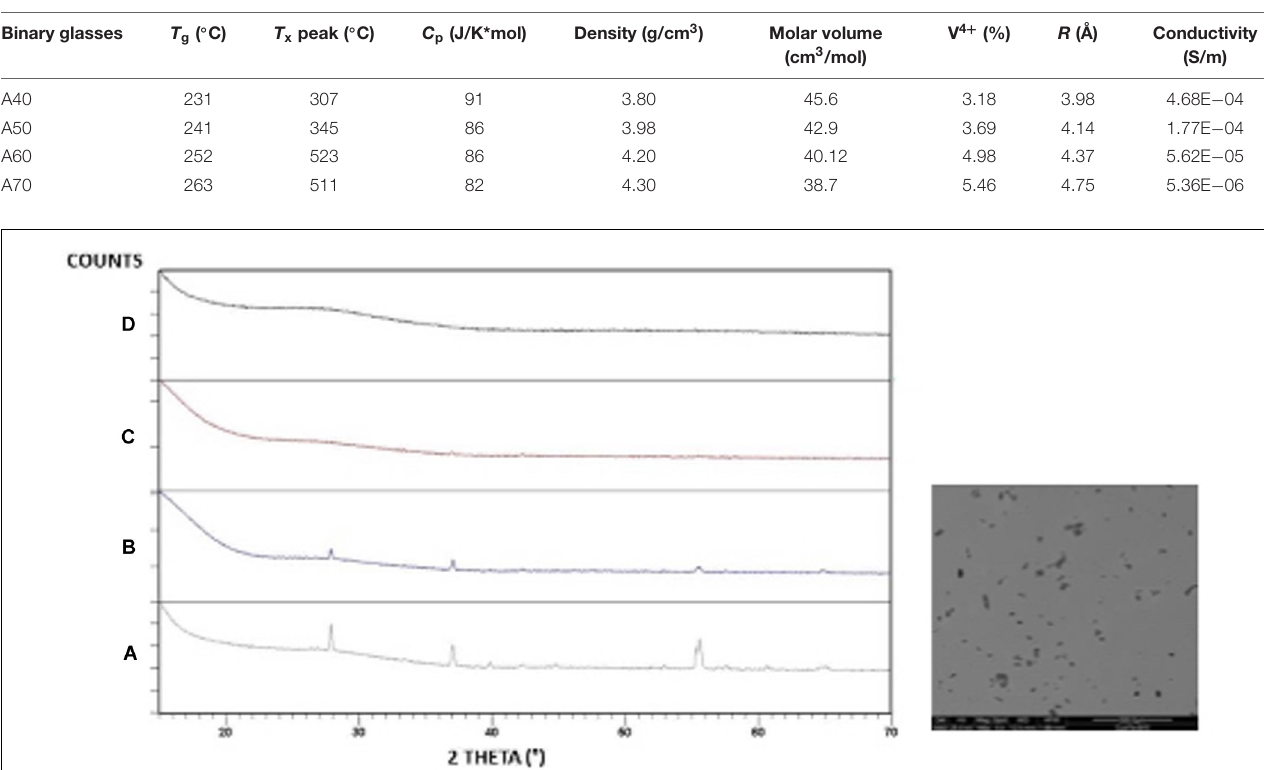
is normally attributed to the lower degrees of freedom of the TeO 4 trigonal bipyramids and the TeO 3 trigonal pyramids (which also have two terminal oxygen